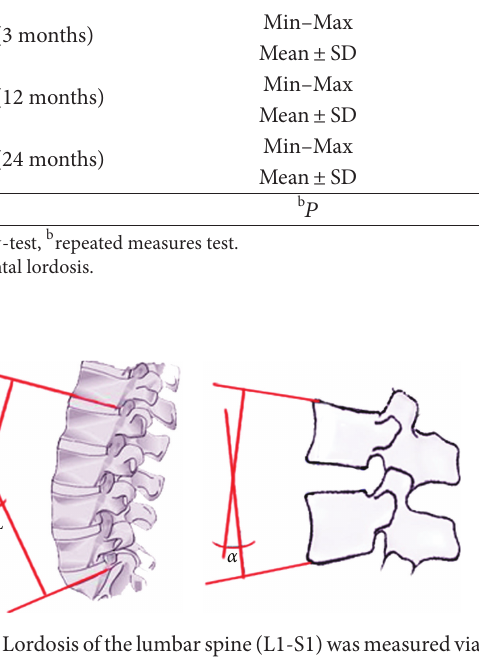
F 4: e data of blood loss in surgery for both groups. ) at the 𝛼𝛼